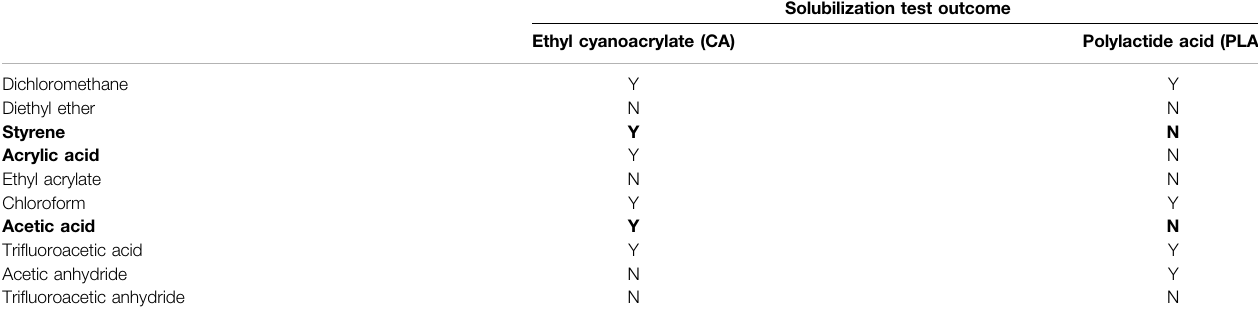
TABLE 1 | Solubility test: Ethyl Cyanoacrylate, Polylactide acid.